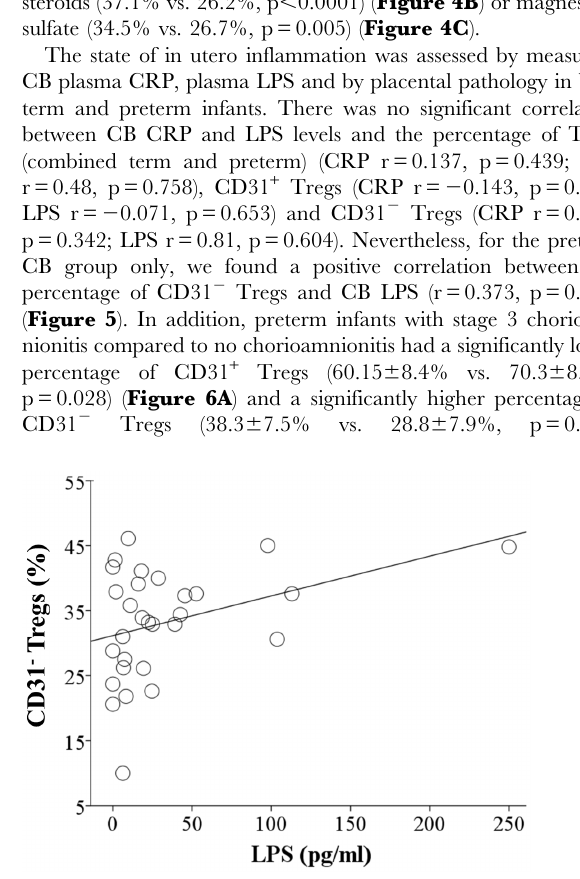
prenatal antibiotics (36.3% vs. 25.6%, p , 0.0001) ( Figure 4A ), steroids (37.1% vs. 26.2%, p , 0.0001) ( Figure 4B ) or magnesium sulfate (34.5% vs. 26.7%, p= 0.005) ( Figure 4C ).